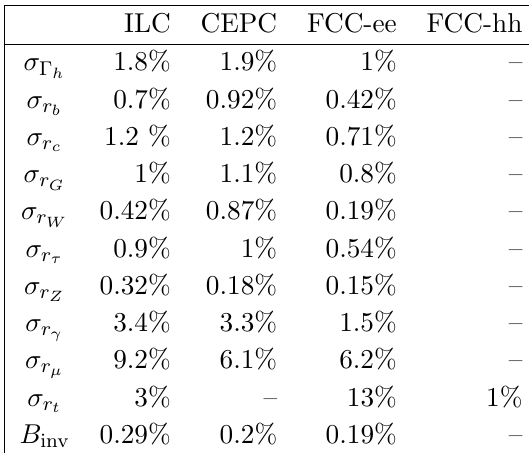
{ Table 5 . Constraints on sensitivities for ILC (250 GeV, 2 ab (cid:0) 1 (cid:8) 350 GeV, 200 fb (cid:0) 1 (cid:8) 550 GeV, 4 ab (cid:0) 1 ) [71], CEPC (240 GeV, 10 ab (cid:0) 1 ) [72], FCC-ee (240 GeV, 10 ab (cid:0) 1 (cid:8) 350 GeV, 2.6 ab (cid:0) 1 ) from [48, 93], and FCC-hh (100 TeV, 30 ab (cid:0) 1 ) [48]. Note that since most of sensitivities of FCC-hh are still under study (except for r t ) [48], we use the corresponding values from FCC-ee for our projections. B inv in the last row are the upper limits with 95%